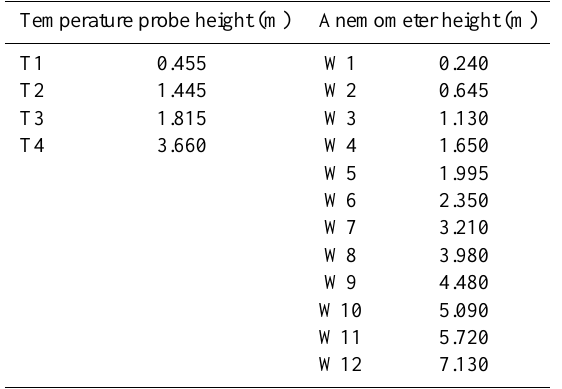
Table 2. Heights for temperature (T) and wind (W) measurements. Table 3. Aerodynamic roughness length ( z 0 ) , displacement height ( D ) and wind friction velocity ( u ∗ ) for various ridge characteristics (spacing: RS ; height: RH